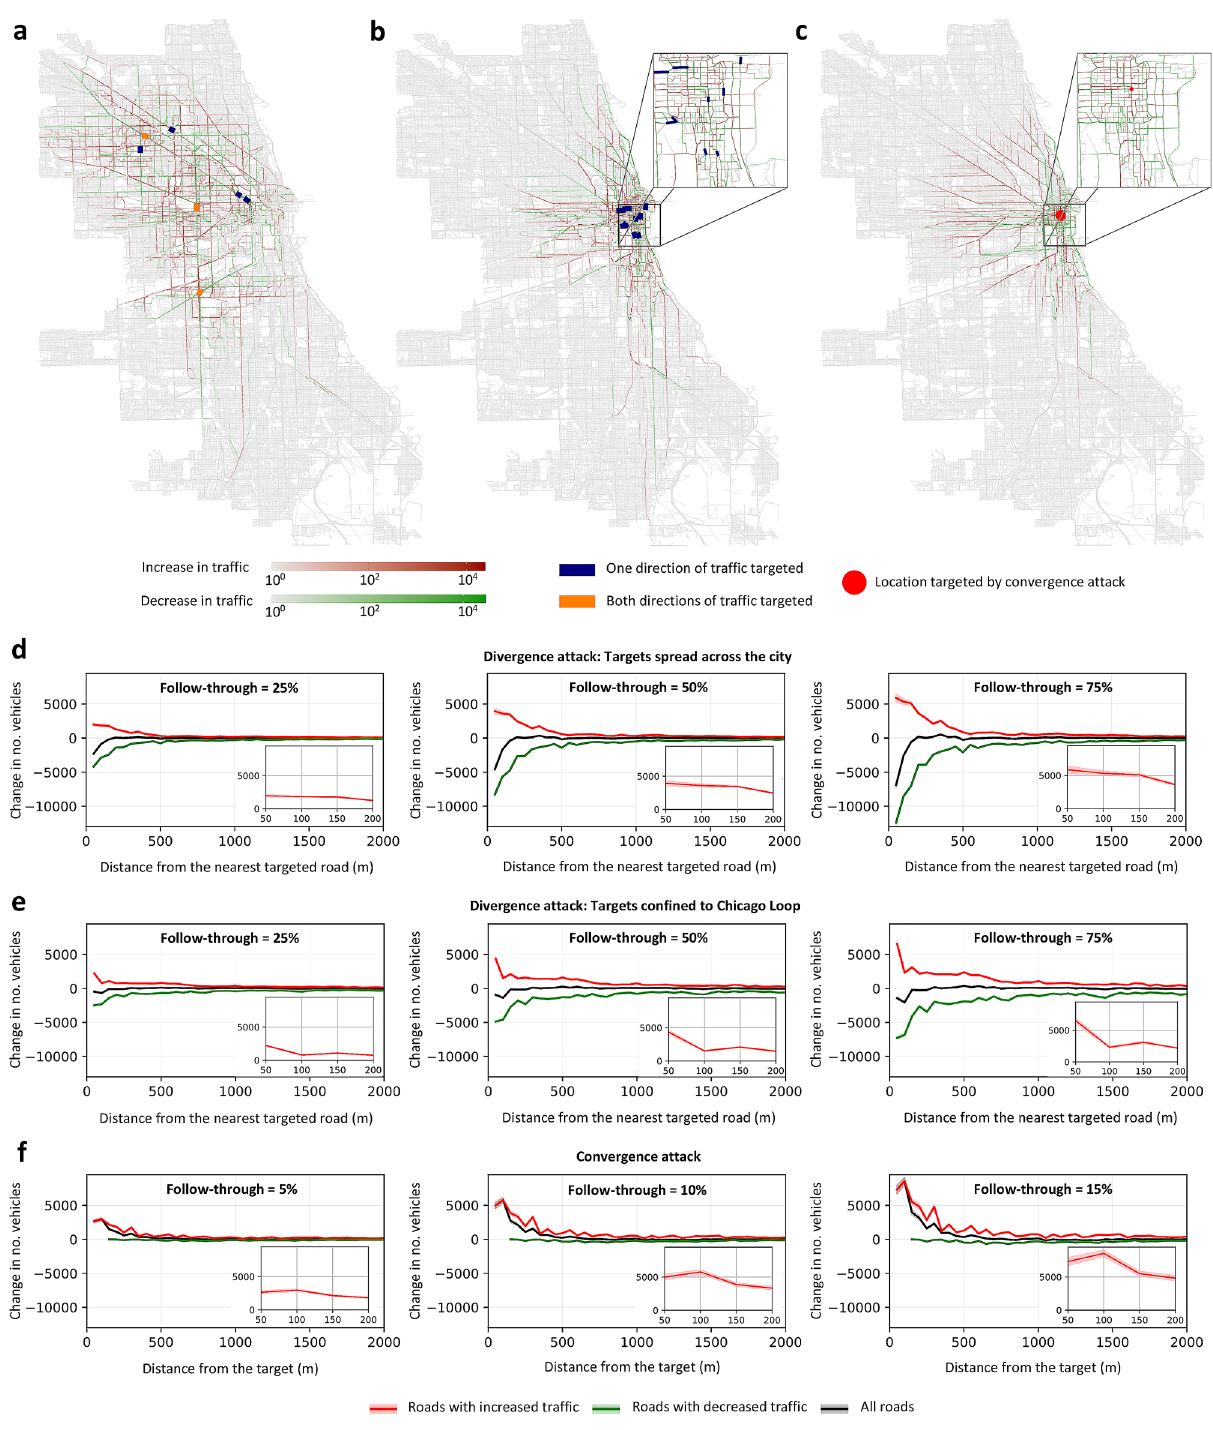
Figure 2. Impact on streets across the city. ( a ) Given a divergence attack with 10 targets, thick lines indicate the streets targeted by our greedy heuristic. Dark blue indicates streets where only a single direction of traffic is targeted, whereas orange indicates streets that contain two targets that cover both directions of traffic. For all remaining streets, the color indicates the change in the number of vehicles passing through when the follow-though rate is 50%, with green indicating fewer vehicles, red more vehicles, and grey no change. ( b ) The same as ( a ) but the greedy heuristic is now confined to a particular neighborhood in downtown Chicago, namely, the Loop. ( c ) The same as ( a ) but instead of a divergence attack, we now have a convergence attack on the store called “Target” located in downtown Chicago. ( d ) The change in traffic per day as a function of the distance (in meters) from the nearest target, given the targets shown in ( a ) and different disinformation follow-through rates. The black plot corresponds to all roads, whereas the red and green plots correspond to only those roads where the traffic increased and decreased, respectively. The inset figures present a zoomed-in view of the red plots in the near-vicinity of the targets. Results are averaged over 100 simulations, with the shaded areas representing the 95% confidence intervals. ( e ) The same as ( d ) but for the target locations shown in ( b ). ( f ) The same as ( d ) but for the convergence attack on the location shown in ( c ). The maps were generated using iText PDF library version 5.2.0 45